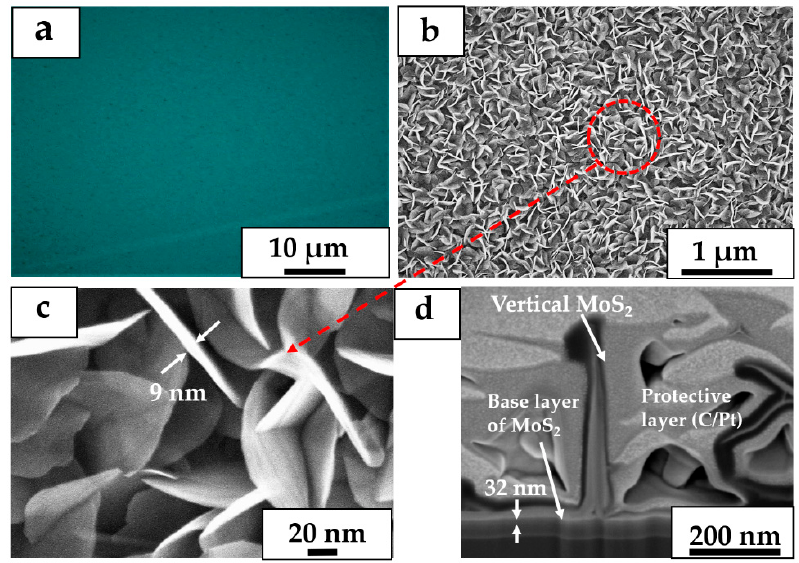
Figure 1. ( a ) Optical microscope image of the material surface. ( b ) Typical SEM image of a vertical MoS 2 nanosheet. ( c ) Randomly grown vertical MoS 2 nanosheet. ( d ) Cross-sectional FIB image of vertical MoS 2 .